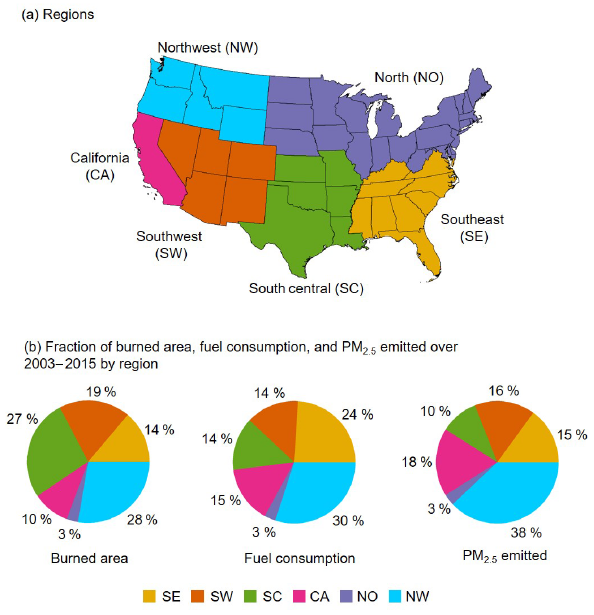
Figure 14. (a) Geographic regions. (b) Burned area, fuel consump- tion, and PM 2 . 5 emitted by